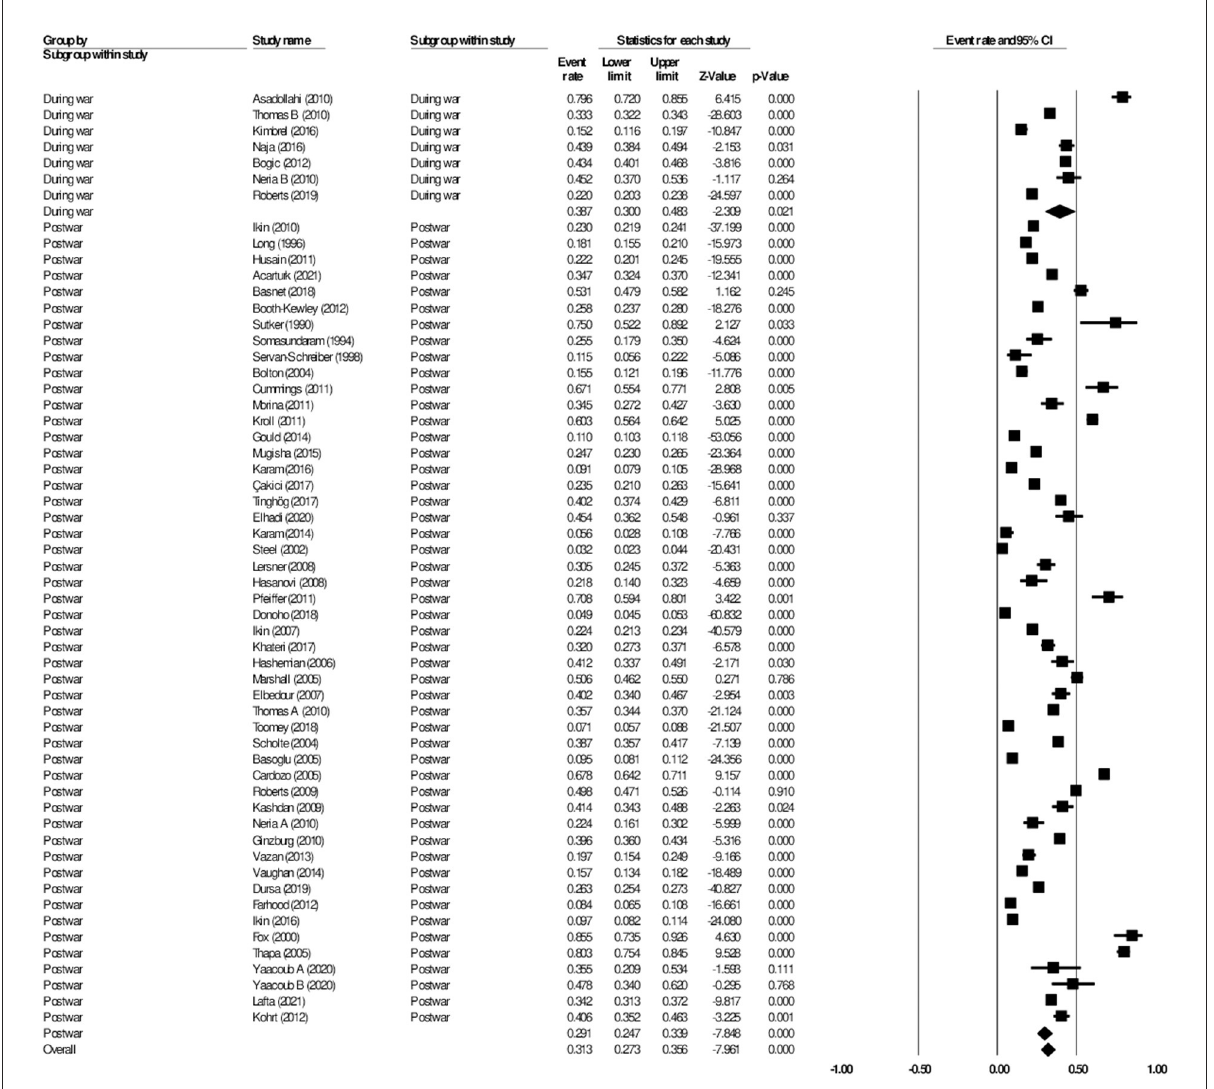
FIGURE3 Forest plot showing prevalence of depression during and